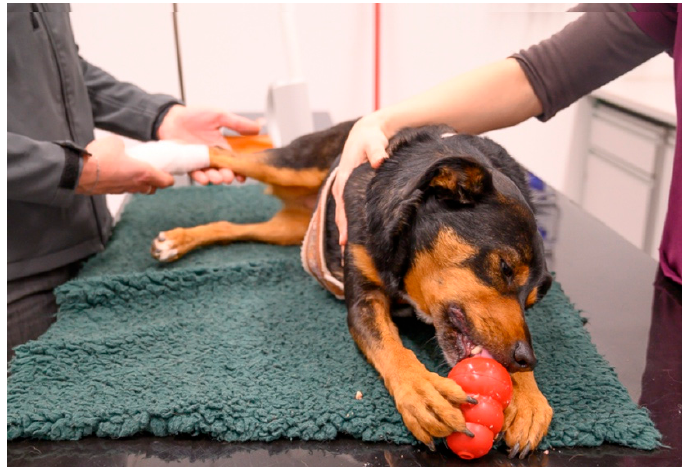
Figure 3. A non-slip mat improves the animal’s comfort. By feeding the animal during the exami- nation or treatment, positive associations can be created. Photo: Christine Arhant, Vetmeduni Vienna.